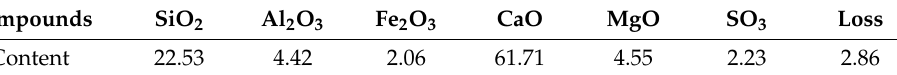
Table 2. Chemical properties of Portland cement (%).